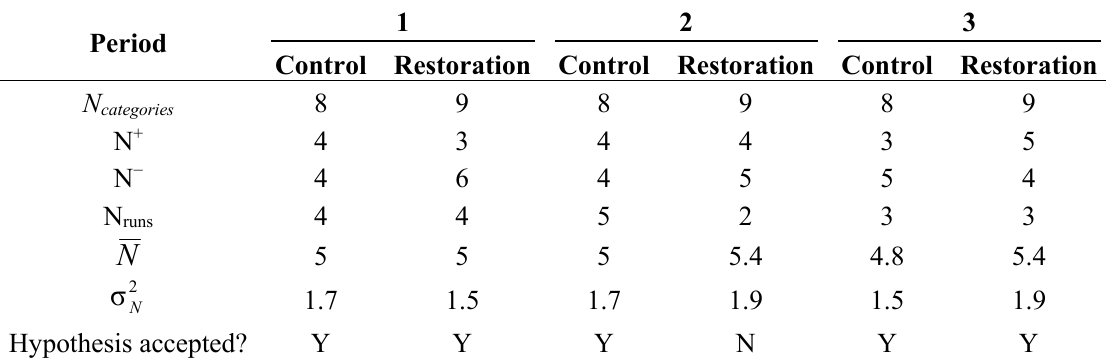
Table 3. Assessment of trend in relation between mobility and particle size in control and restored reaches using the runs test [62]. The rejection of the hypothesis means that the relation between particle size and mobility is significant, which is indicative of partial